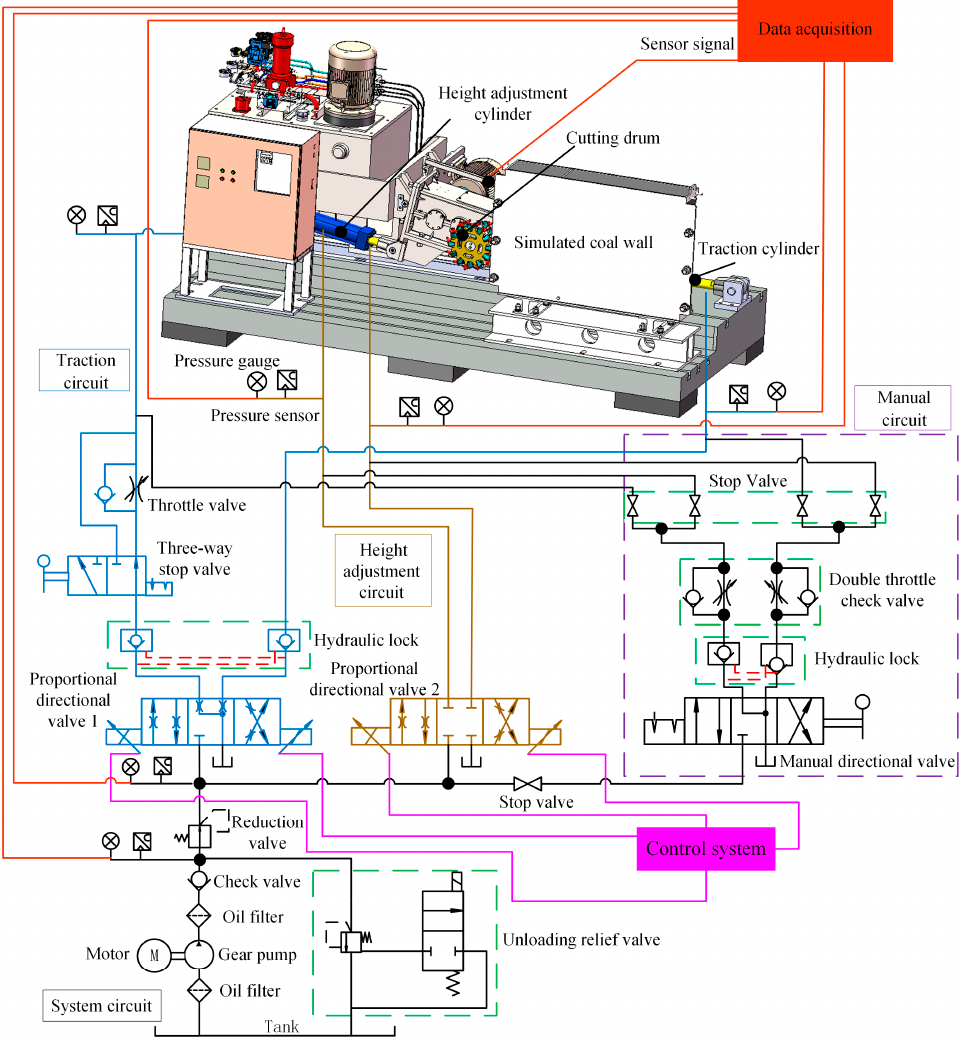
Figure 3. Schematic diagram of the hydraulic system.